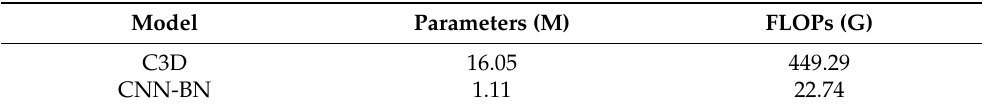
Table 3. Comparison of the number of parameters and the number of floating-point operations (FLOPs) between the regular CNN (C3D) model and the proposed CNN-BN